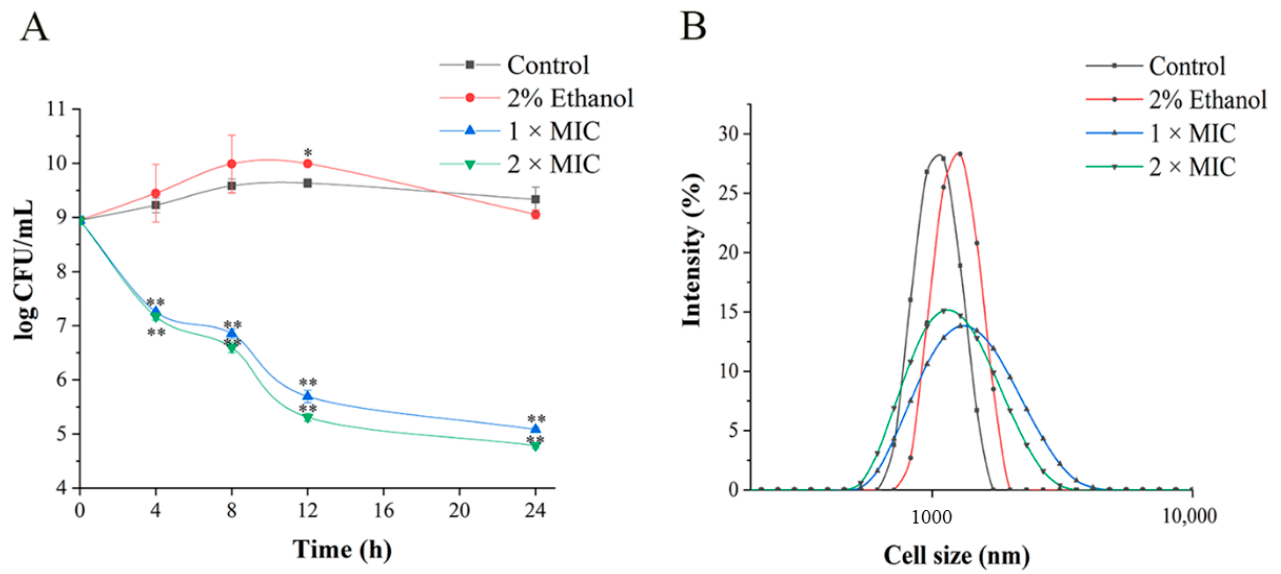
Figure 1. Time–kill curves analysis ( A ). The distribution of cell size ( B ). The asterisks indicate statistically significant differences compared with the control (* p < 0.05; ** p < 0.01).